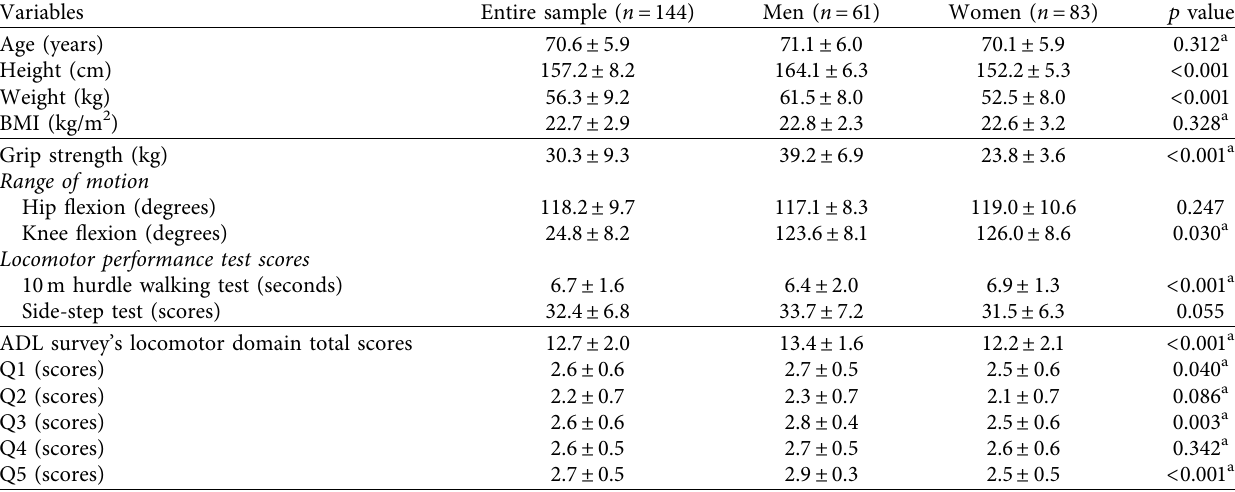
Table 2: Physical characteristics, grip strength, range of motion, locomotor performance test scores, and ADL survey’s locomotor domain (mean ± SD).